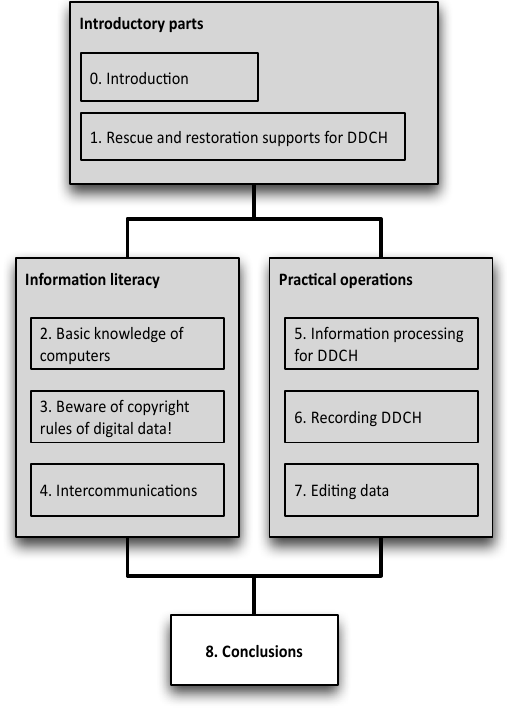
Figure 5: Unit structure of the CEDCHeLi 1; it was designed